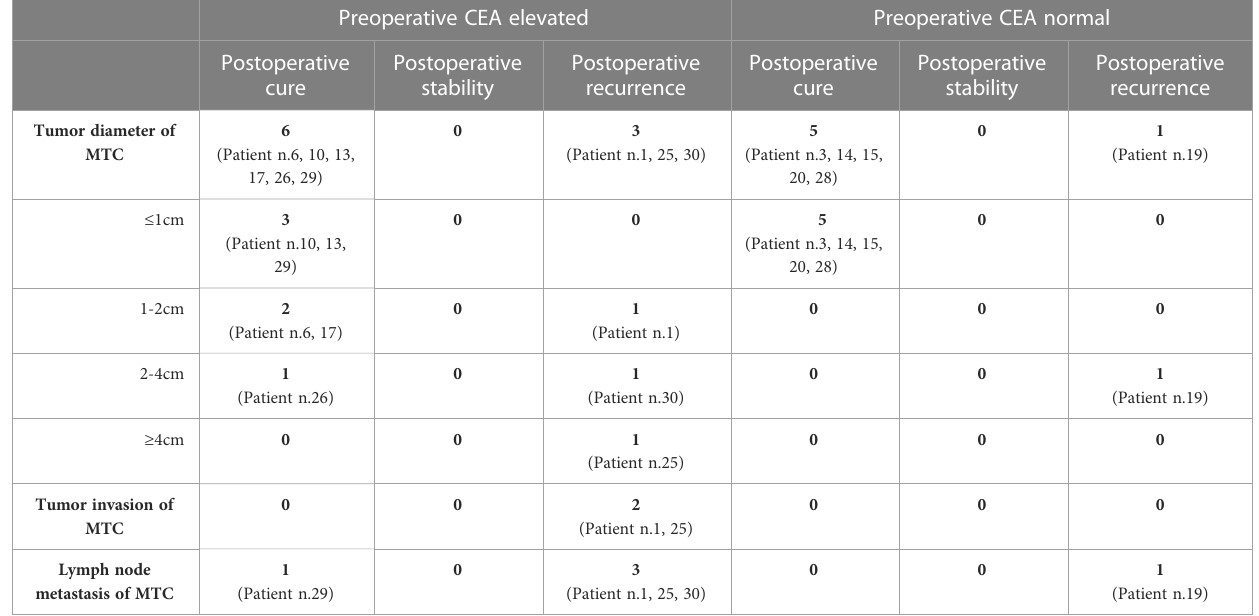
TABLE 5 Relationship between CEA changes and clinicopathological